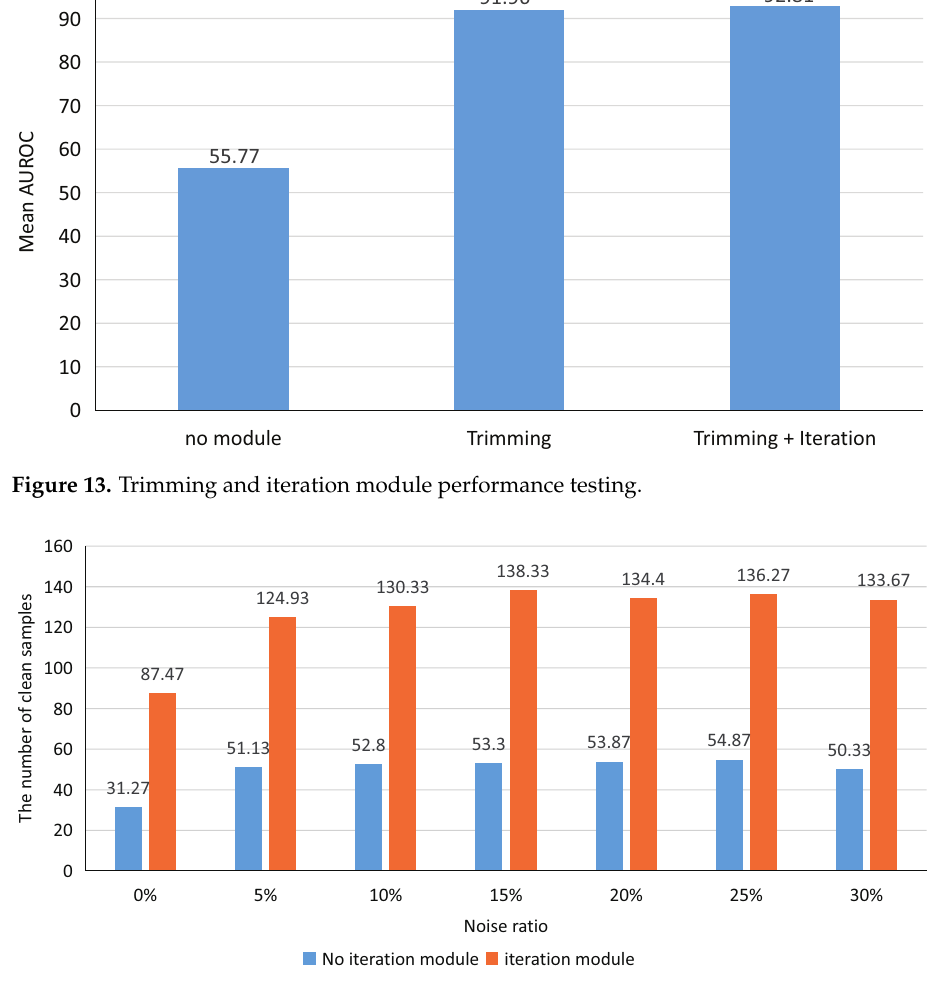
Figure 14. Comparison of the number of clean samples with and without the iteration